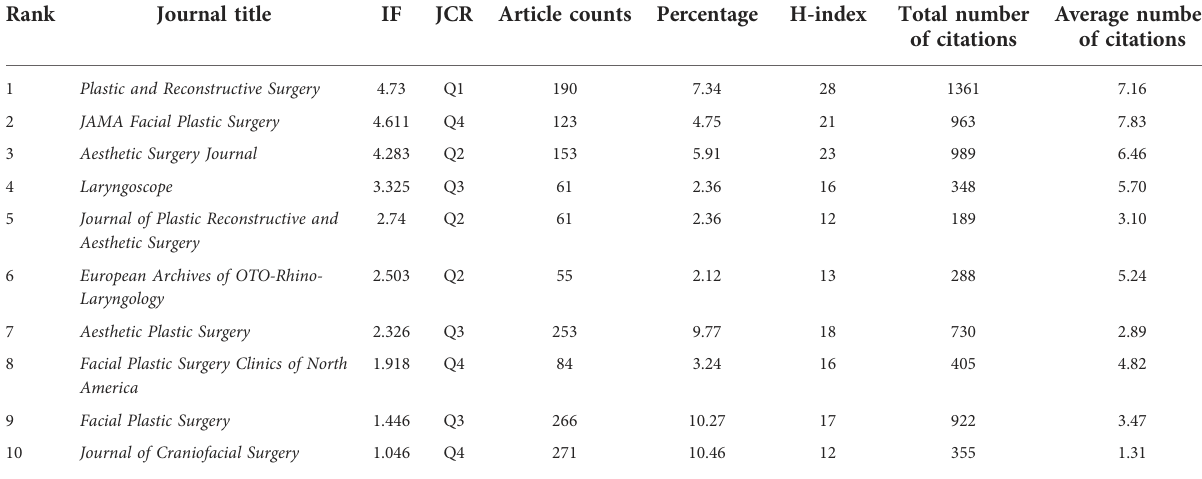
TABLE 3 The top 10 most active journals that published articles in rhinoplasty research (sorted by IF). Rank Journal title IF JCR Article counts Percentage Total number